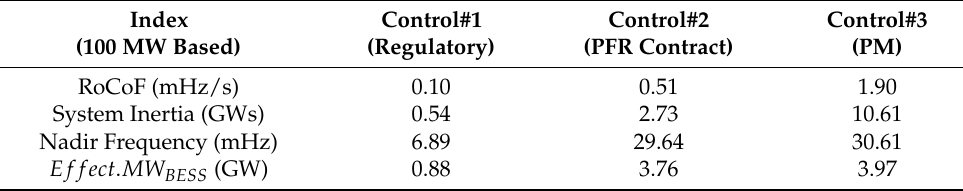
Table 4. Analysis on evaluation performance of control methods by